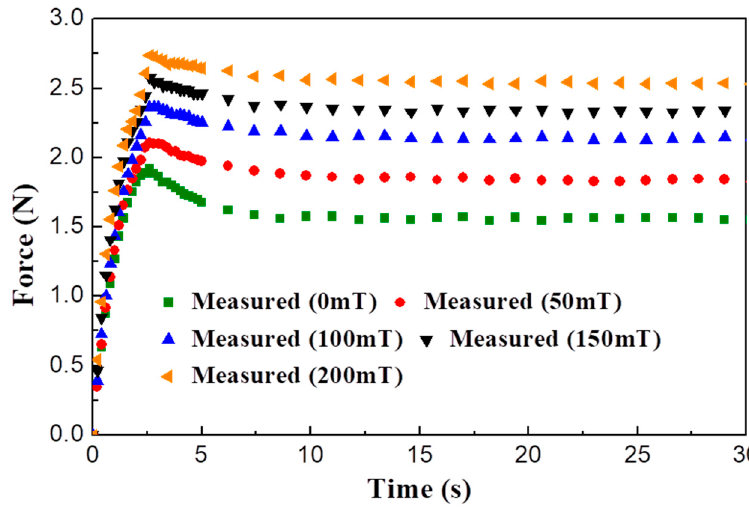
Figure 8. The field-dependent force of MR sponge.